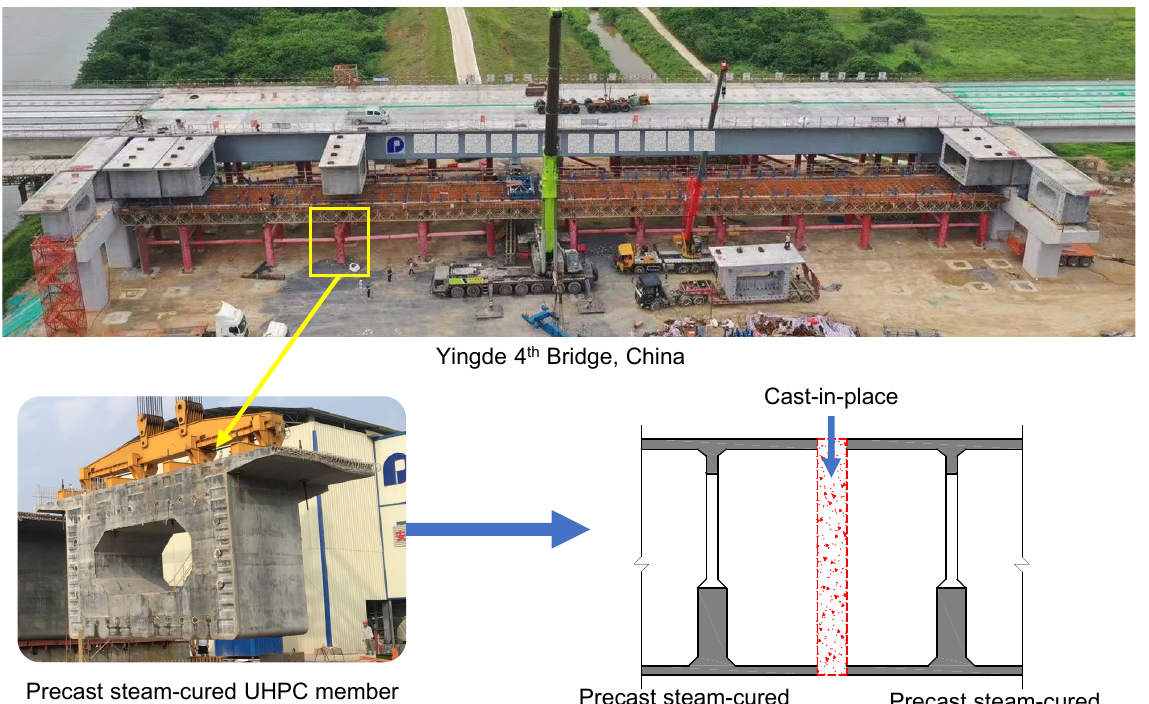
Figure 1. Accelerated bridge construction using ultra-high performance concrete (UHPC) for the fourth Yingde